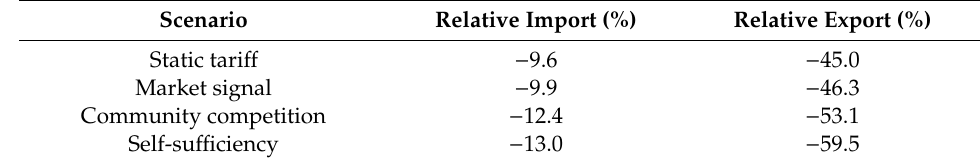
Table 7. Changes in the community energy system’s import and export 1